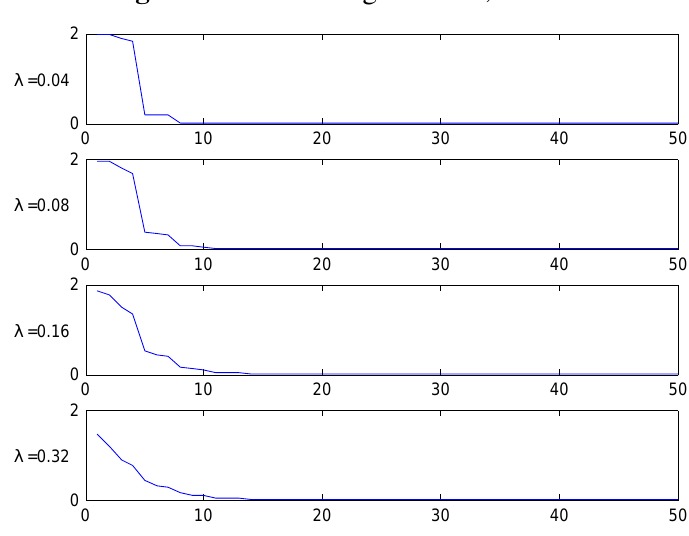
Figure 4. T.v. convergence rate,